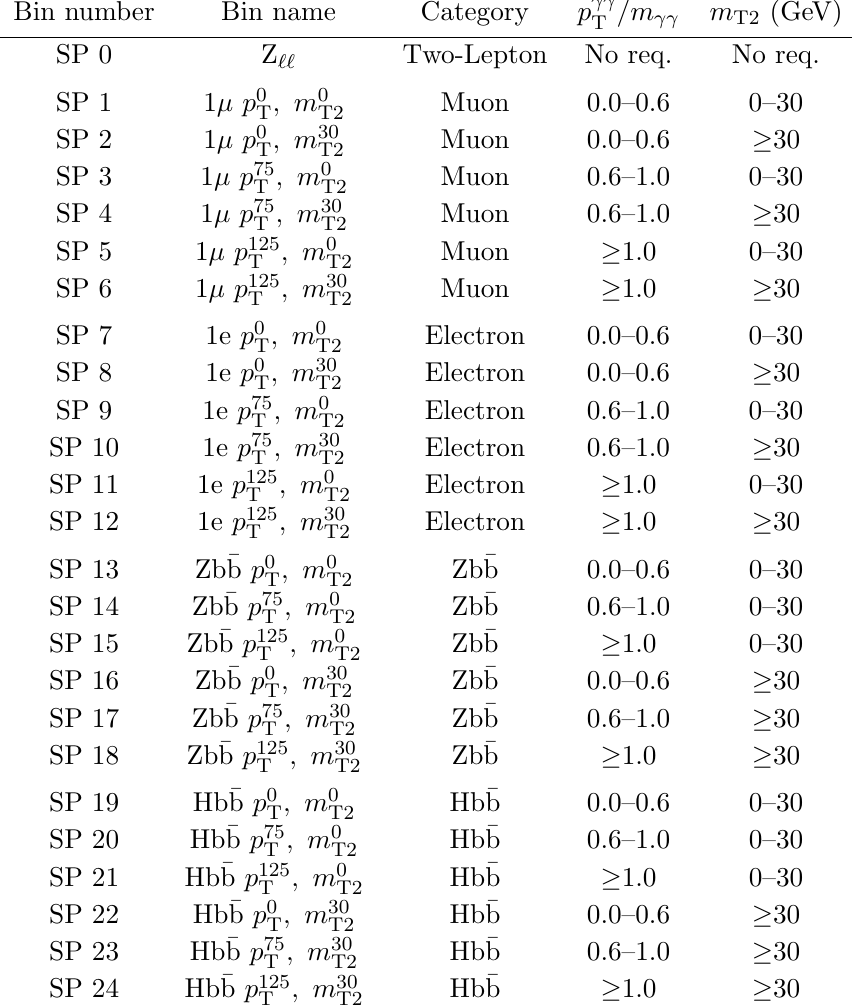
Table 2 . A summary of the search region bins in the leptonic and Higgs boson categories used in the SP analysis, along with the requirements on p (cid:13)(cid:13) =m (cid:13)(cid:13) and m T2 . There are no explicit requirements T on the number of jets or b-tagged jets for these categories. For the Two-Lepton category, \No req." means that no requirements are placed on the given observables.